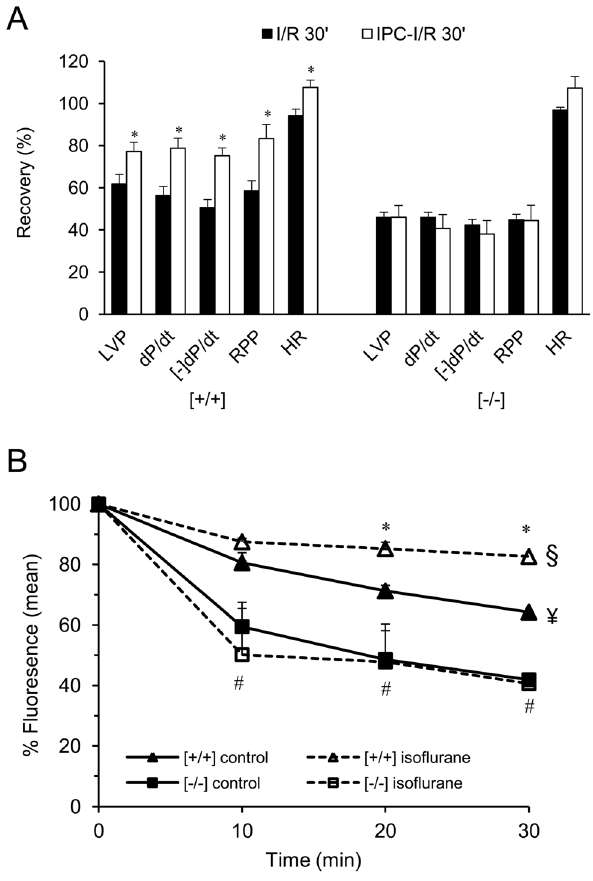
Figure 9. No preconditioning in Popdc1 -null hearts and cardiomyocytes. (a) WT and mutant hearts underwent I/R perfusion with and without IPC. Parameters of LV function registered at 30 min reperfusion are shown. Labels are as in Figure 1. Mean 6 SEM; *P , 0.05, I/R vs. IPC-I/R within a genotype. (N=5–9/group). (b) Wild type and mutant cardiomyocytes were preconditioned with isoflurane (1.5%) or left untreated, then loaded with calcein-AM and exposed to H 2 O 2 (200 m M). The change in calcein fluorescence with time of H 2 O 2 treatment is shown. Summary of three experiments performed in triplicates. *P , 0.05, WT ( Popdc1 [ + / + ] ) cells, isoflurane vs. untreated control. # P , 0.05, control Popdc1 [ 2 / 2 ] vs. control Popdc1 [ + / + ] (isoflurane-untreated cells, open symbols). In the curve comparisons (ANOVA with multiple repeats), 1 P , 0.05, Popdc1 [ + / + ] isoflurane vs. Popdc [ + / + ] control; ¥ P , 0.05 Popdc1 [ + / + ] control vs. Popdc1 [ 2 / 2 ]